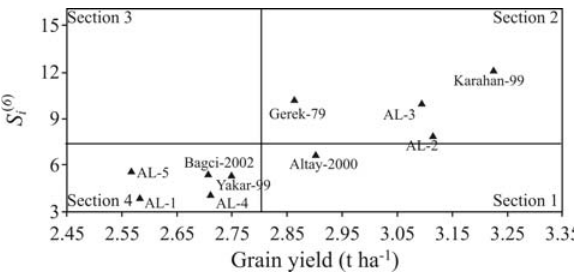
Figure 4 - Plot of the sum of the squares of ranks for each genotype rela- tive to the mean of ranks ( S i ( 6 ) ) against mean grain yield ( gy , t ha -1 ) for 10 bread wheat genotypes over environments.